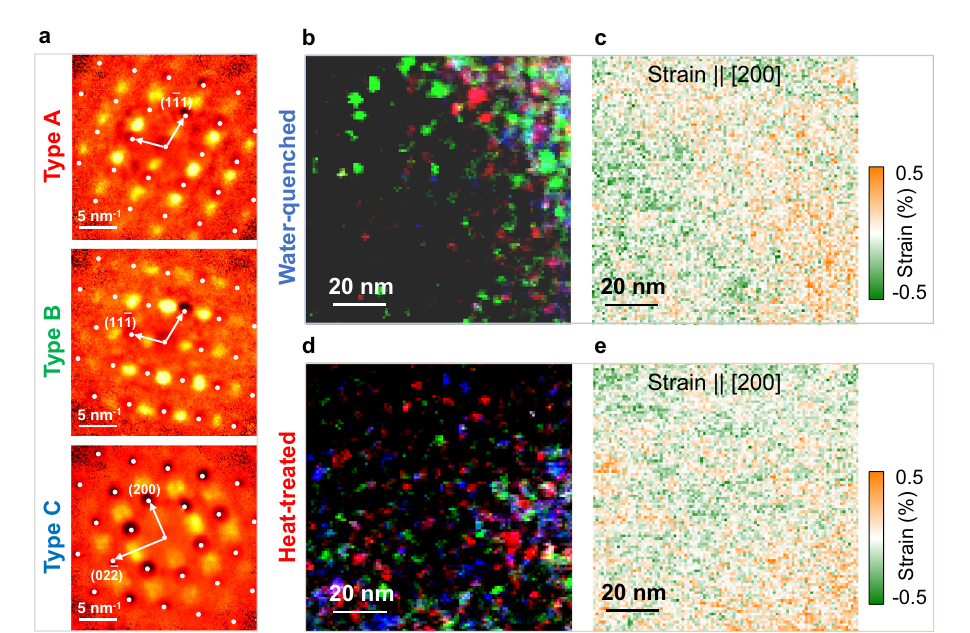
Fig.3|Theidenti fi edCSROdiffuse-scatteringpatternsandtheirdistributionin CrCoNi. a Three types (A, B, and C) of diffuse-scattering patterns along [011], detectedby EF-SEND in bothwater-quenched (WQ)and heat-treated(HT)samples (the white dots mark Bragg peak positions). b and d are composite color images formed by integrating the diffuse-scattering intensity for Type A (red), Type-B